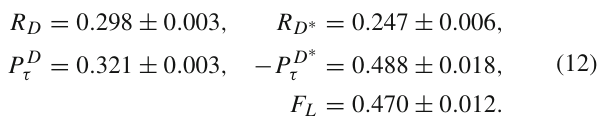
( 1 ) in the 2 / 1 / 0 fit model with χ 2 (cid:12) 4 3